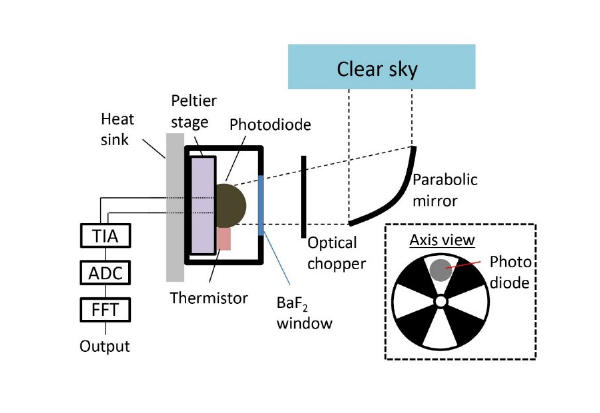
Fig. 1 Schematic diagram of insulator infrared experimental